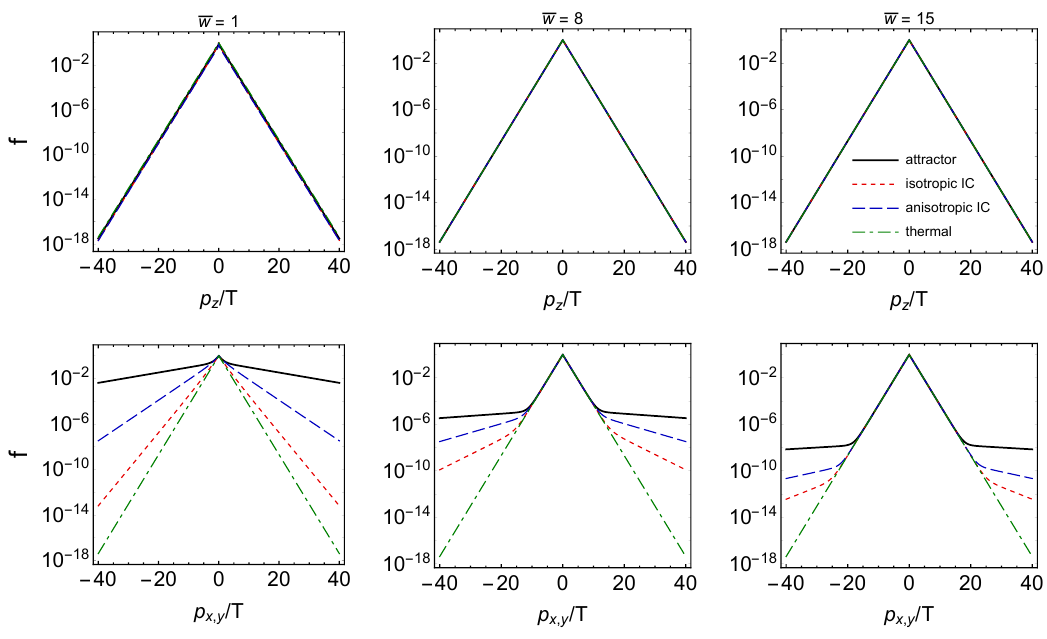
Figure 10 . Attractor for the full distribution function at larger momenta. The labeling etc. is the same as in (cid:12)gure 9.